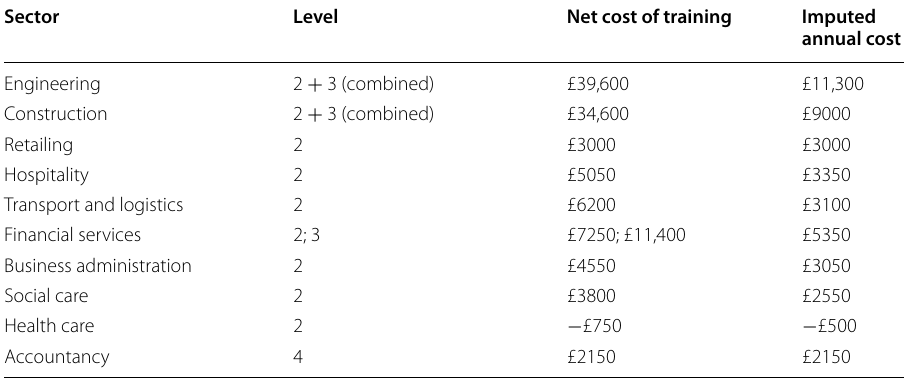
Table 2 Summary of Employers’ Net Training Costs in 2011. Source: Net Costs Studies